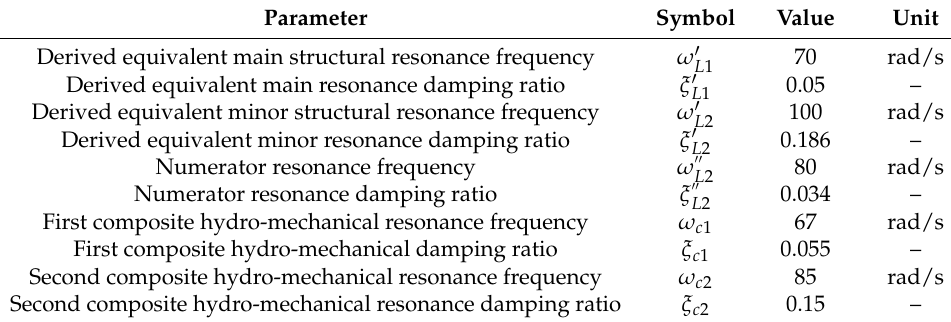
Table 3. The identified parameters of the fourth-order load model. Parameter